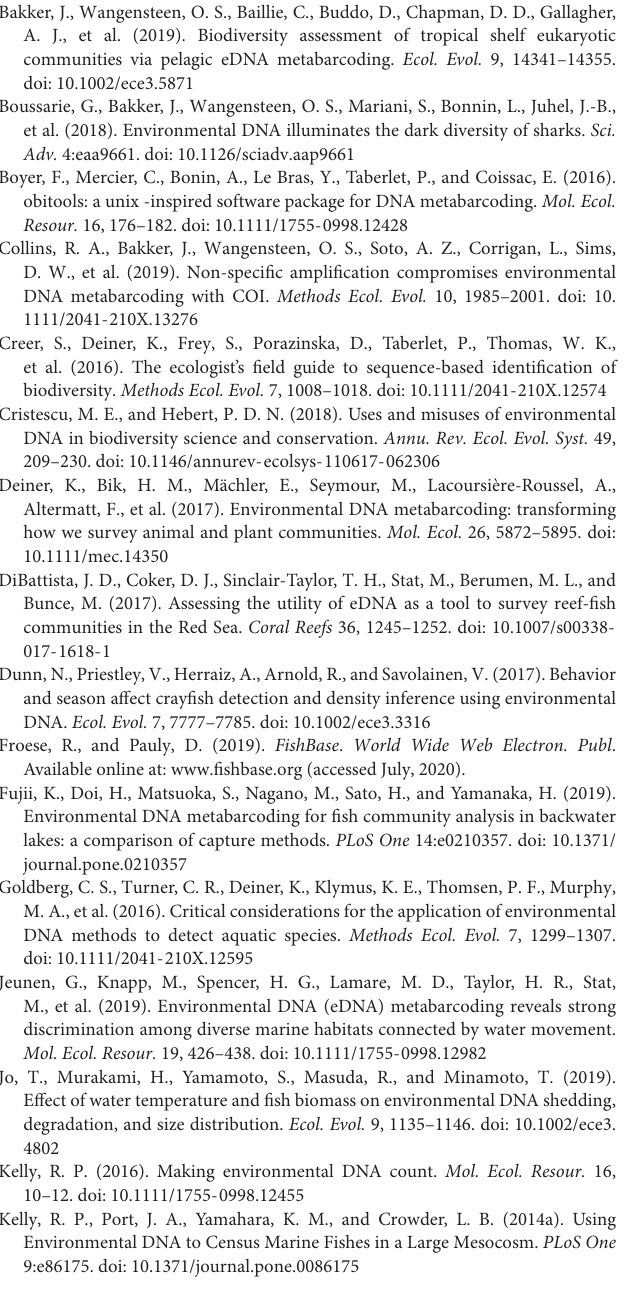
plot shows the difference in number of reads between two PCR replicates of the same sample. Supplementary Figure 4 | Non-metric multidimensional scaling (nMDS) ordination of fish communities obtained from sponge nsDNA based on Bray-Curtis distances. Colors show differences between locations. Each environment is represented by a different shape. Supplementary Figure 5 | Heatmap based on relative abundance data of fish communities ( x -axis) recovered from sponge nsDNA. Replicates of the same sample ( y -axis) are indicated by “a” or “b.” Cluster dendrograms of MOTUs and